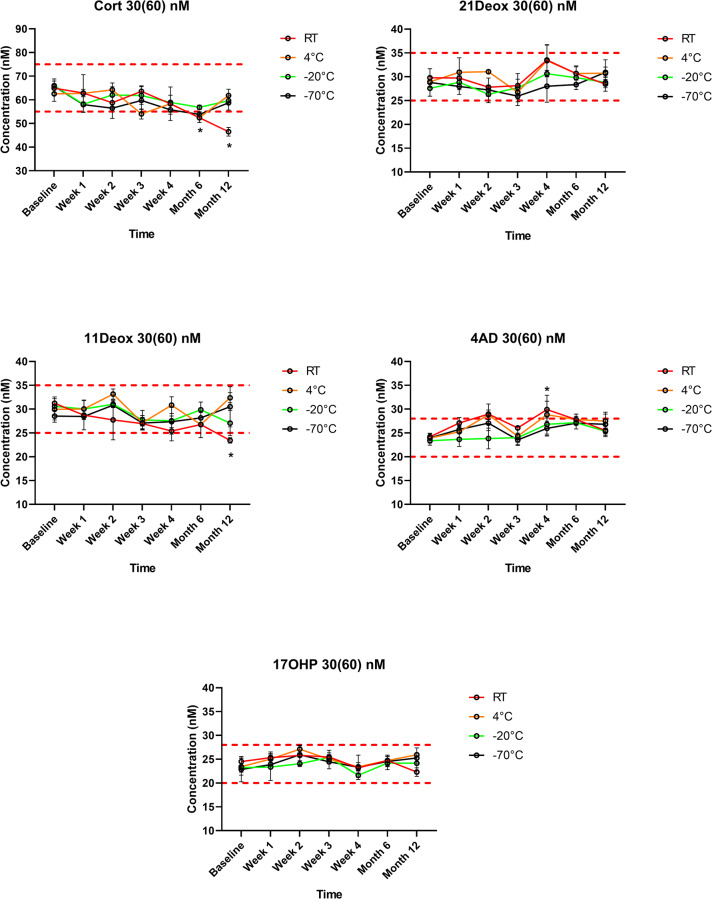
Steroid concentrations in the 30(60) nM test samples during storage within 1 year at different temperatures (n = 3 for each data point).Values are given as means±SD. Cort: cortisol; 21Deox: 21-deoxycortisol; 11Deox: 11-deoxycortisol; 4AD: 4-androstenedione; 17OHP: 17-hydroxyprogesterone; RT: room temperature. Dashed red lines indicate upper and lower cutoffs of the predetermined ranges (±15% vs Week 0), within which analytes were considered stable. * p<0.01 vs the baseline at room temperature. Error bars for SD values smaller than the respective symbol size are not visible.